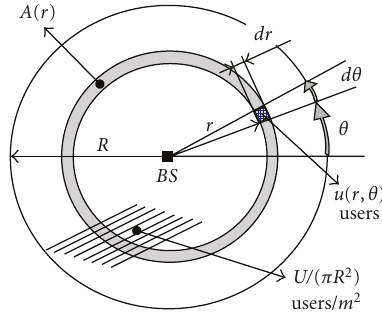
Figure 3: Di ff erential annular zone A ( r